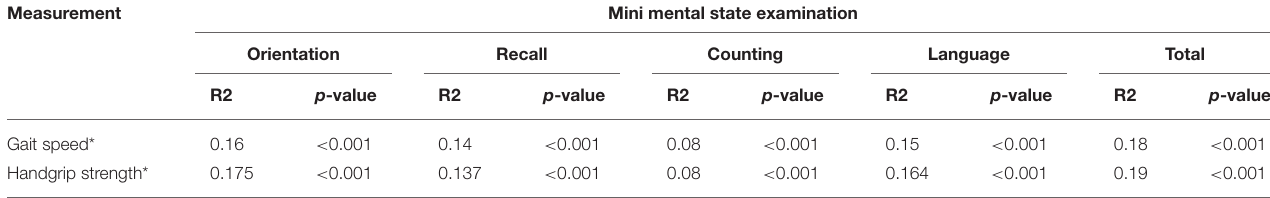
TABLE 2 | Association between motor function and cognitive domains. Measurement